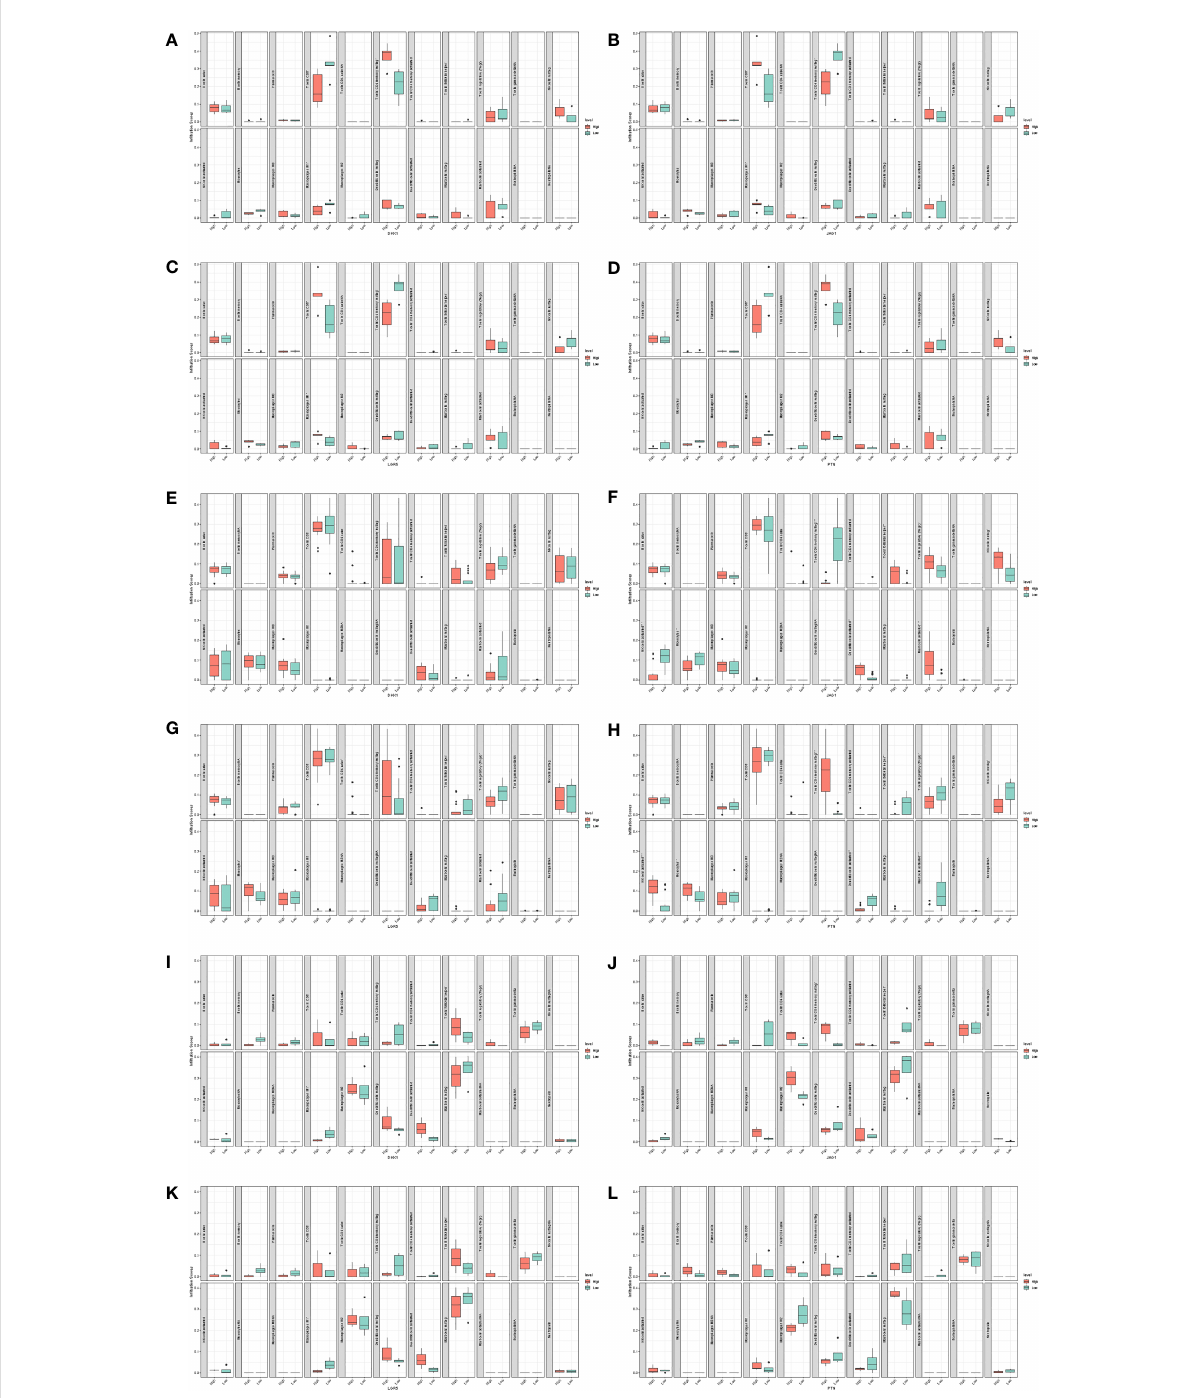
FIGURE 10 Immune in fi ltration analysis. (A) DKK1 in GSE7890. (B) JAG1 in GSE7890. (C) LGR5 in GSE7890. (D) PTN in GSE7890. (E) DKK1 in GSE44270. (F) JAG1 in GSE44270. (G) LGR5 in GSE44270. (H) PTN in GSE44270. (I) DKK1 in GSE92566. (J) JAG1 in GSE92566. (K) LGR5 in GSE92566. (L) PTN in